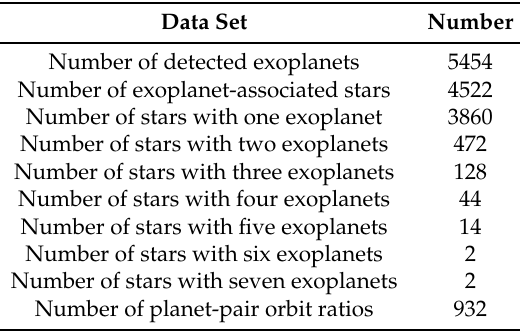
Table 1. Statistics of analyzed data set, using the Exoplanet Orbit Database (EOD) at exoplanets.org (status as of 10 May